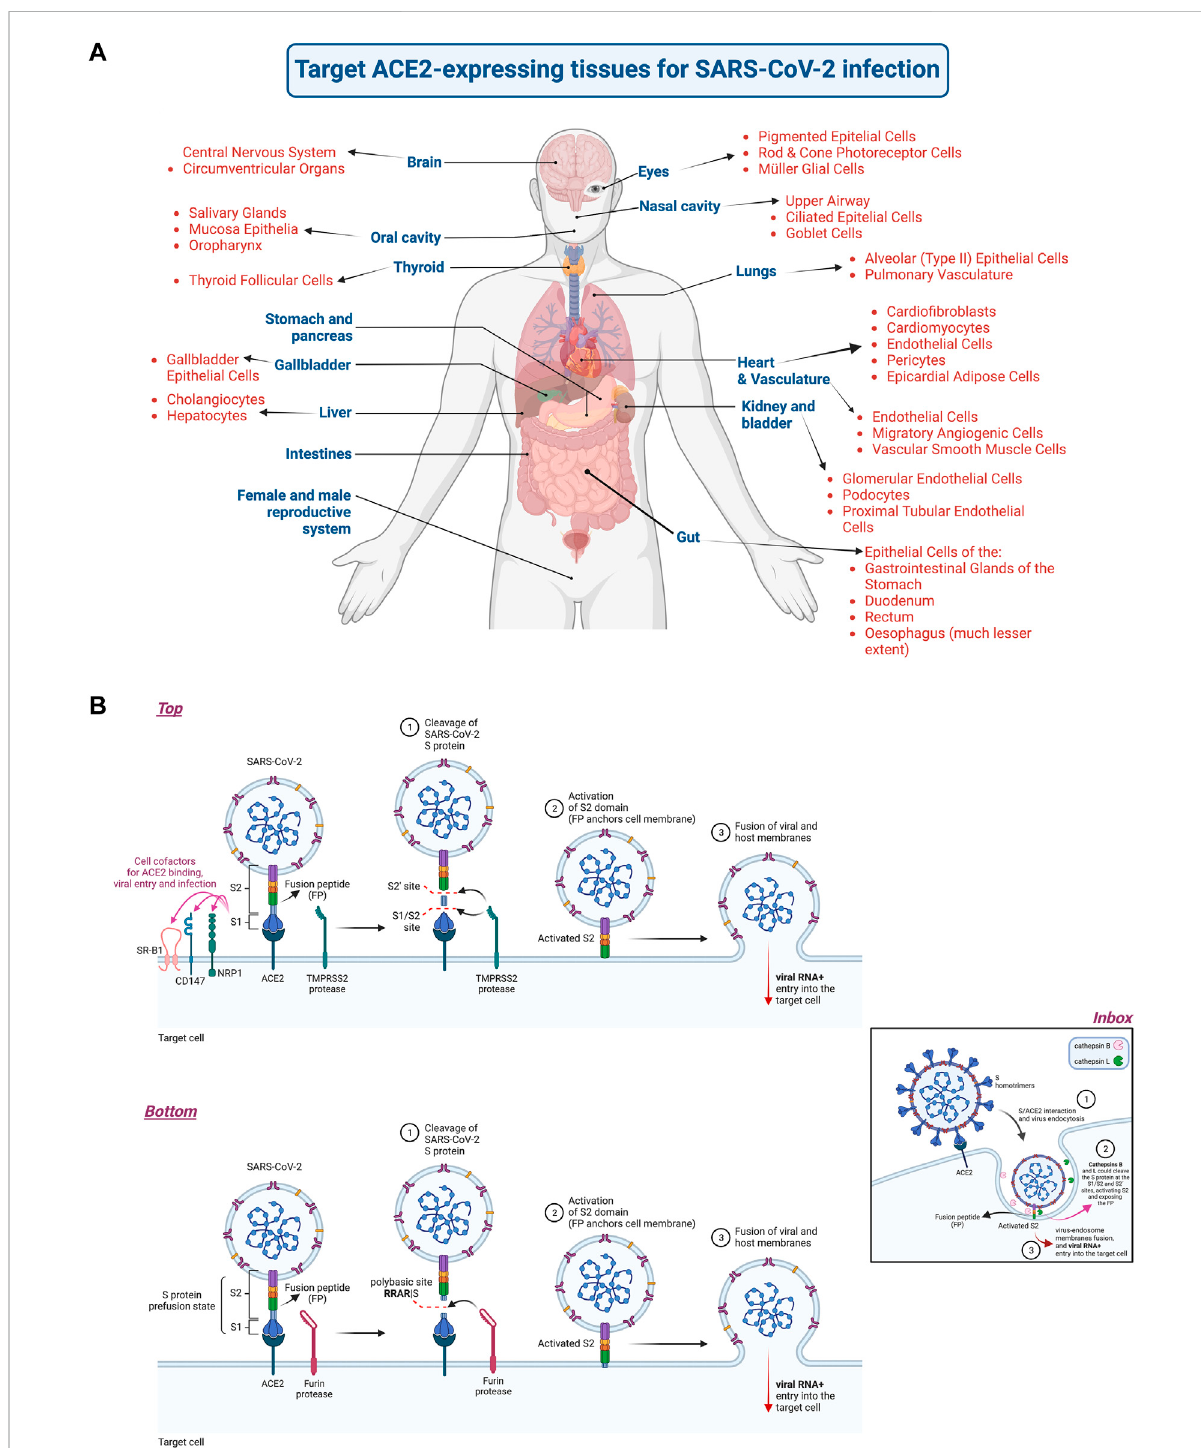
FIGURE 1 Cells, tissues and organs that express the ACE2 receptor and are infected by SARS-CoV-2, and the mechanismsof early SARS-CoV-2 infection. (A) Scheme representing cells, tissues and organs expressing the ACE2 receptor that allows the SARS-CoV-2 virus to infect them, thereby being associated with tissue damage and organ failure. (B) Scheme representing themain viral and cellular molecules involved inSARS-CoV-2 attachment and fusion with target cell that mediate viral entry and infection. The S protein (with its S1 and S2 subunits in the prefusion state) interacts